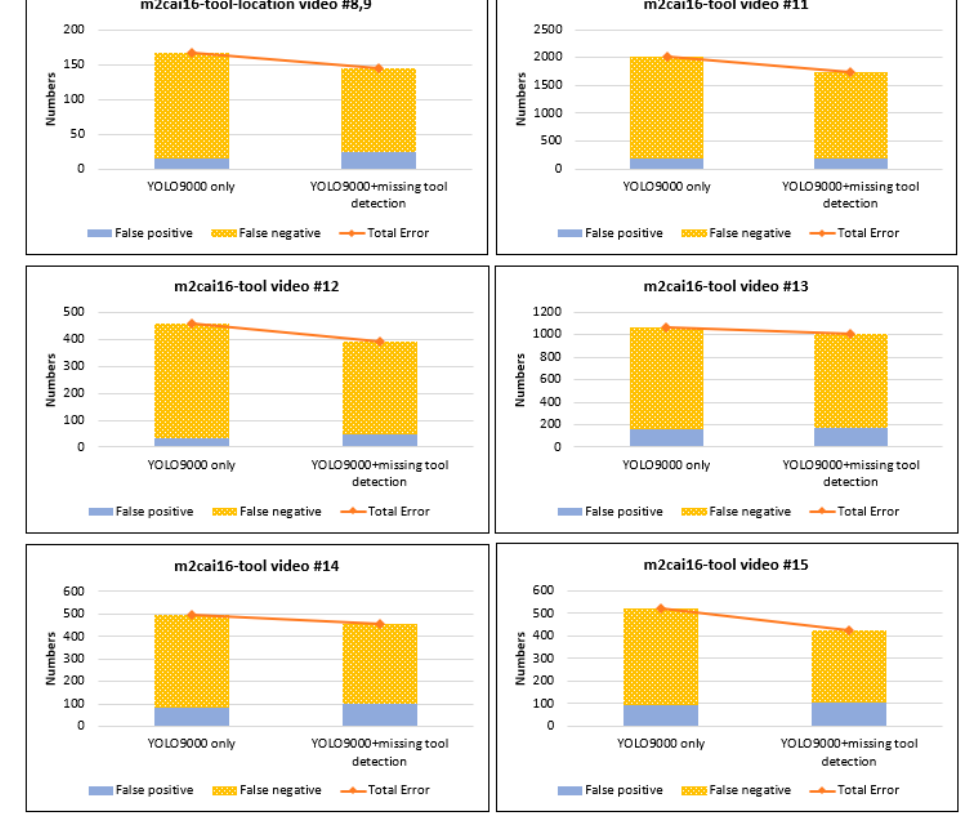
Figure 7. Graph of changes in surgical tool detection error in each test video.